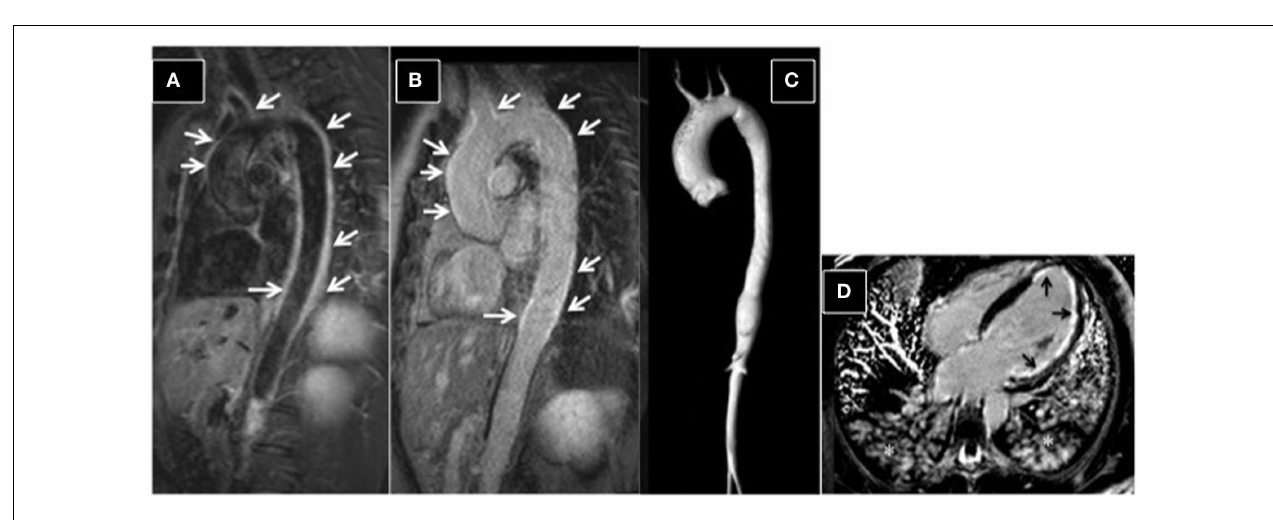
the ascending aorta and narrowing of the descending aorta. (D) Post-contrast four-chamber view, showing extensive sub-endocardial and focally nearly transmural myocardial late enhancement (ischemic late-enhancement pattern) of the apical and lateral left ventricular walls. Asterisks highlight the presence of pulmonary edema; the patient was intubated during the